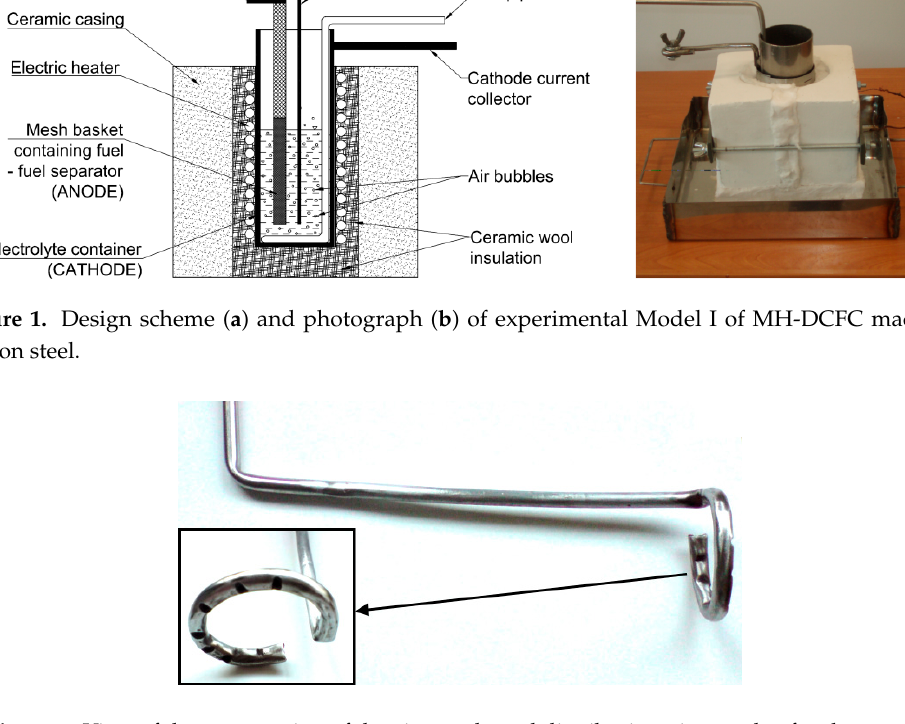
Figure 2. View of the construction of the air supply and distribution pipe made of carbon steel.